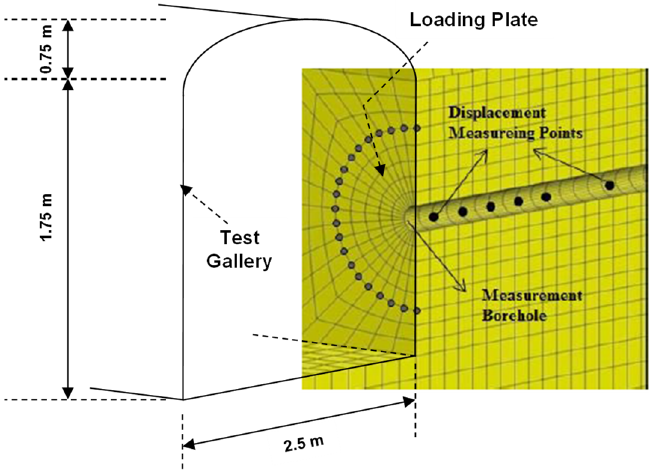
Figure 7. View of the horizontal plate loading test set up implemented within the 3D model.